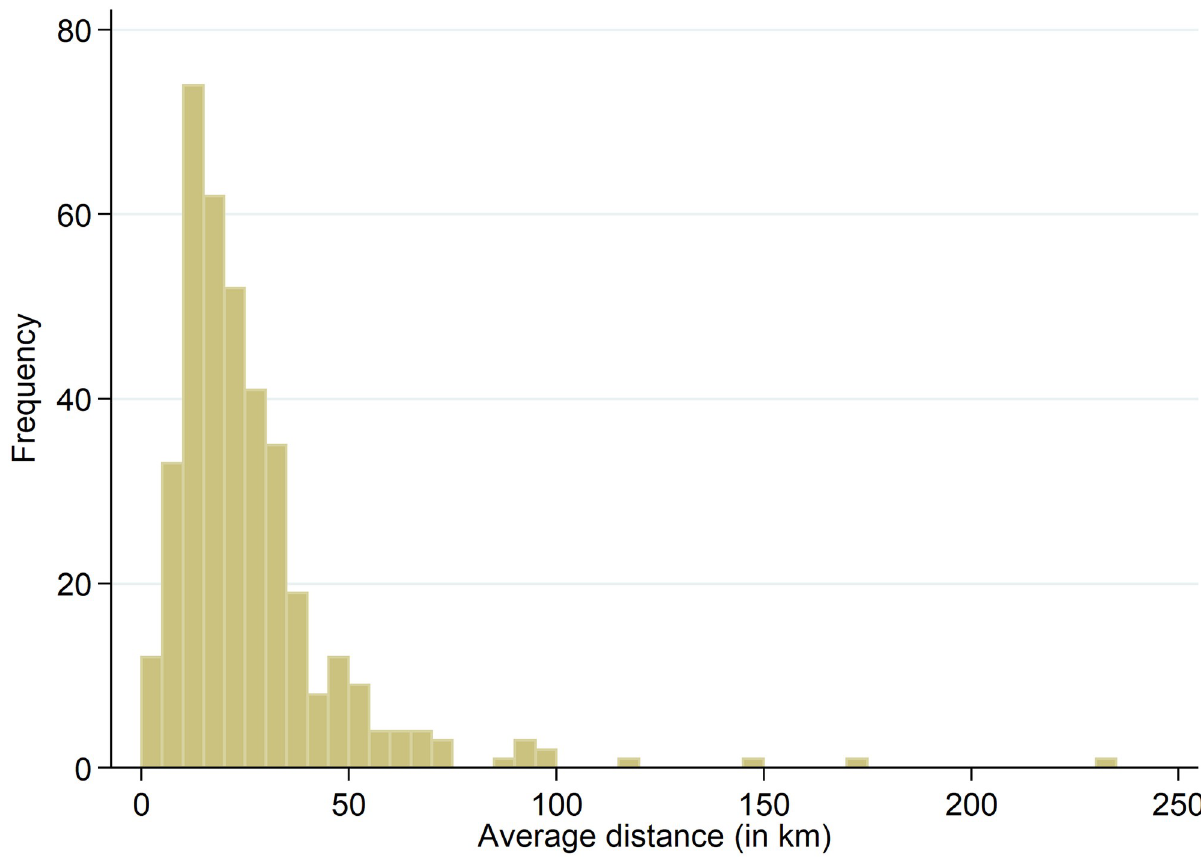
Fig 6. Average distance between full-IP and anonymized geolocations per